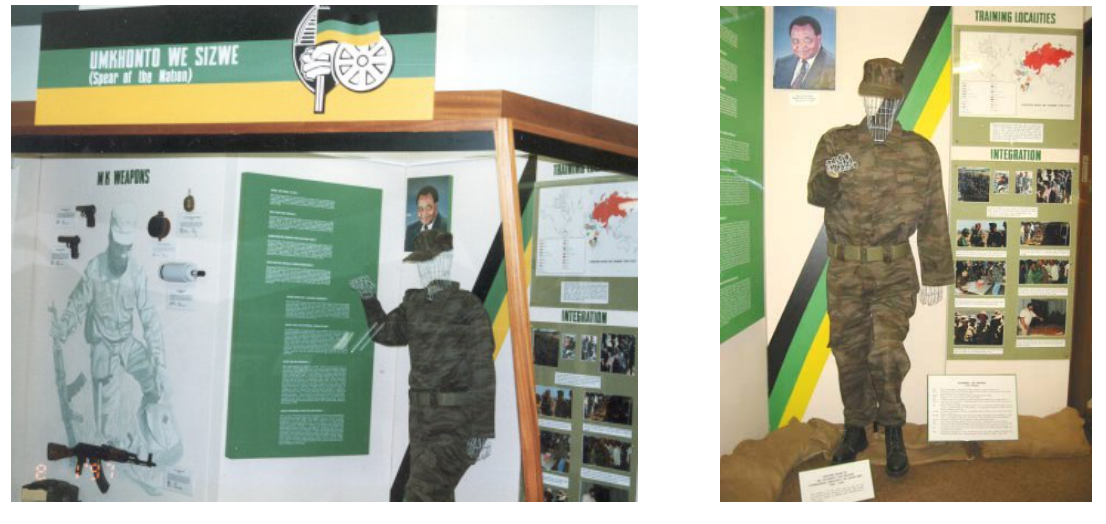
Figure 2. View of the Umkhonto We Sizwe display, Ditsong Museum of Military History, Johannesburg, and detail of Modise’s uniform. (author’s